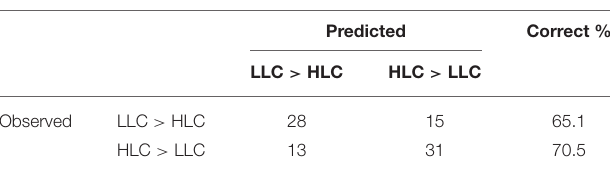
TABLE 4 | Classification